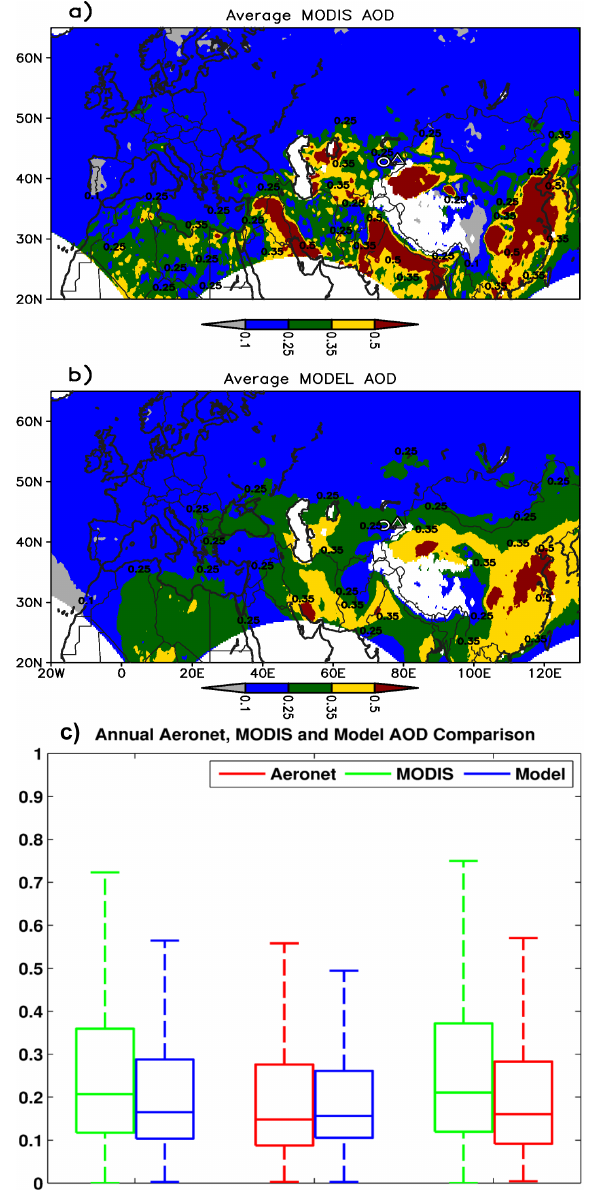
Figure 3. Spatial distribution of (a) MODIS and (b) modeled AOD along with (c) comparison of MODIS, AERONET, and simulated AOD shown as box-and-whisker plots averaged over the simula- tion period. The box plots are based on data that are paired in time and space (see Sect. 3.2.1 for more details). The triangle and circle markers on the spatial plots denote the location of LST and Bishkek sites. The numbers on the map denote contour values at sharp gra- dients. In each box-and-whisker panel, the middle line denotes the median value, while the edges of the box represent 25th and 75th percentile values, respectively. The whiskers denote the maximum and minimum